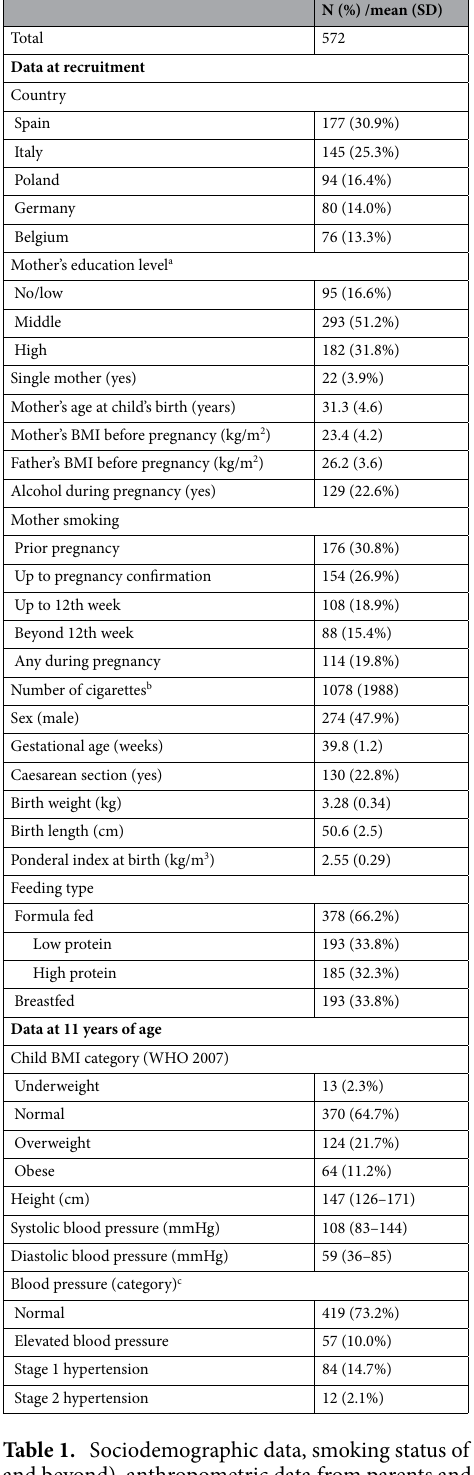
Table 1. Sociodemographic data, smoking status of the mother prior and during pregnancy (first trimester and beyond), anthropometric data from parents and children (at birth and at 11 years of age) and